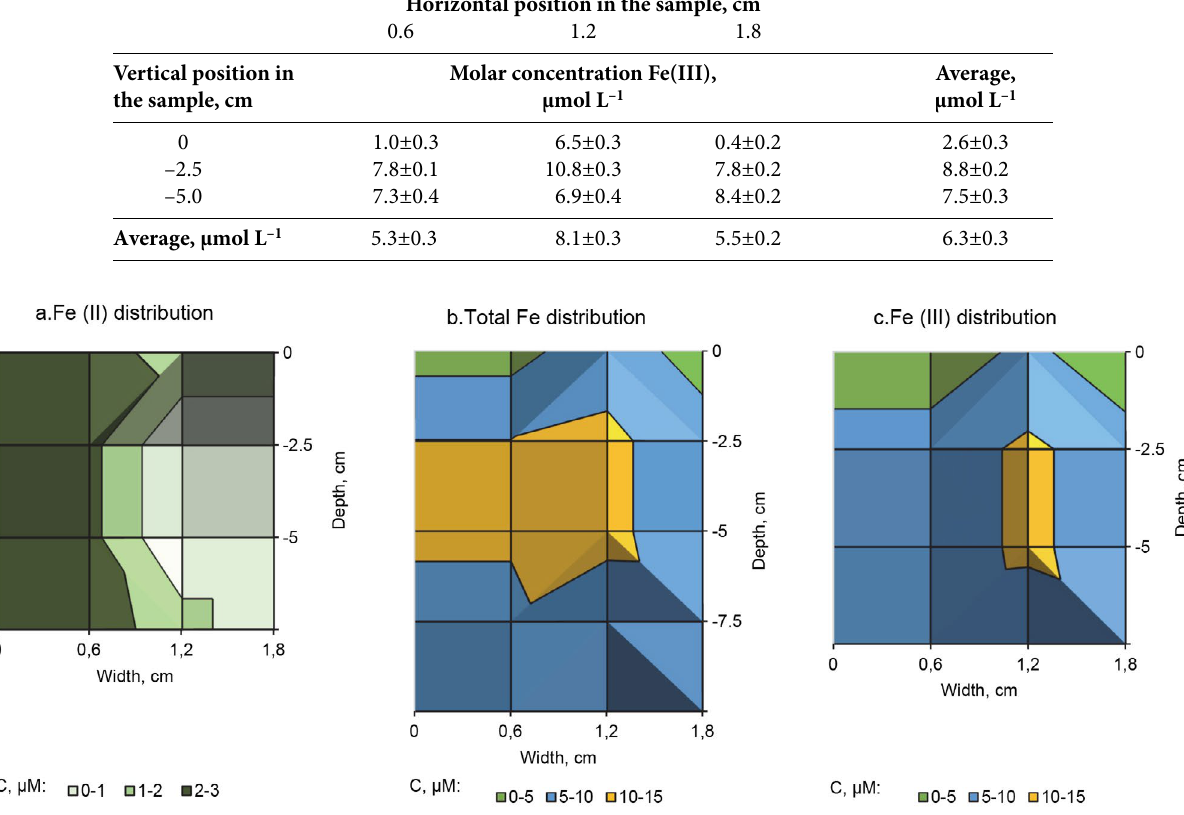
Figure 7. Graphical presentation of Fe redox species distribution in the Chelex-100